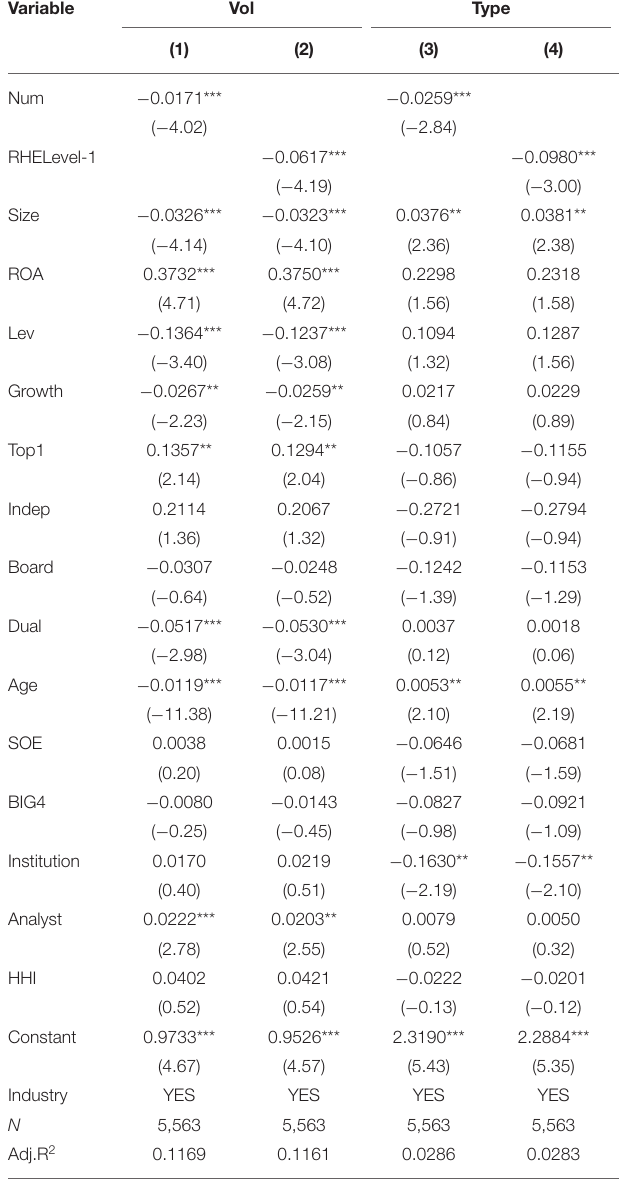
the absolute value decreases, then the partial mediating effect is